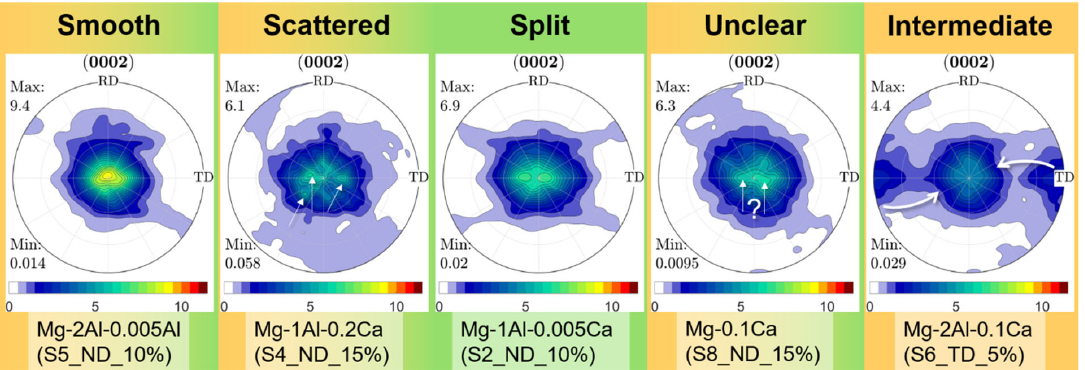
Figure 2. Observed types of pole fi gure for samples with di ff erent compositions and rolling reduc- tions (in %) deformed in normal direction (ND) and transverse direction (TD). Yellow and green background colours indicate whether the type was observed for ND (green), TD (yellow), or both directions.